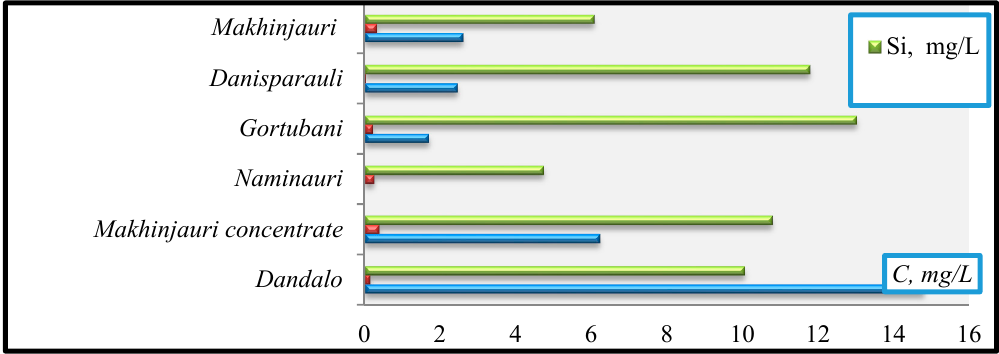
Figure 15. The content of Si, Hg and V in the mineral waters. Appl. Sci. 2020 , 10 , x FOR PEER REVIEW